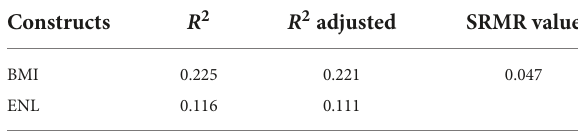
TABLE 6 R 2 and model